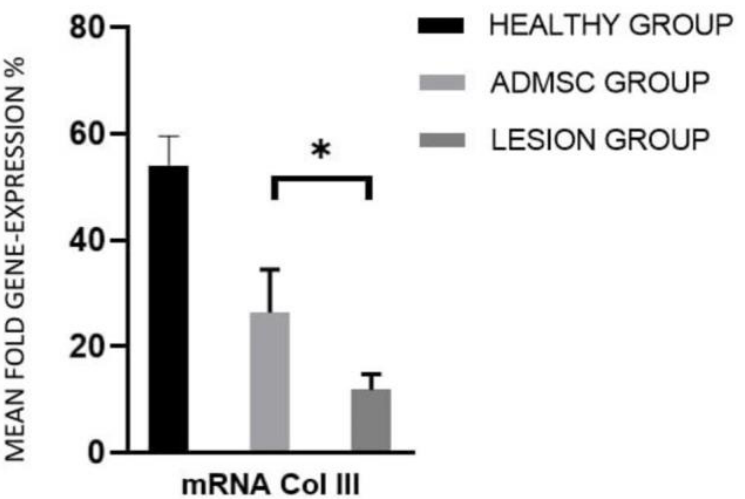
8 Figure 4. Mean fold gene expression % for collagen I relative to GAPDH in healthy, ADMSC, and lesion groups determined by quantitative RT-PCR. Standard error of the mean (SEM) is also de-